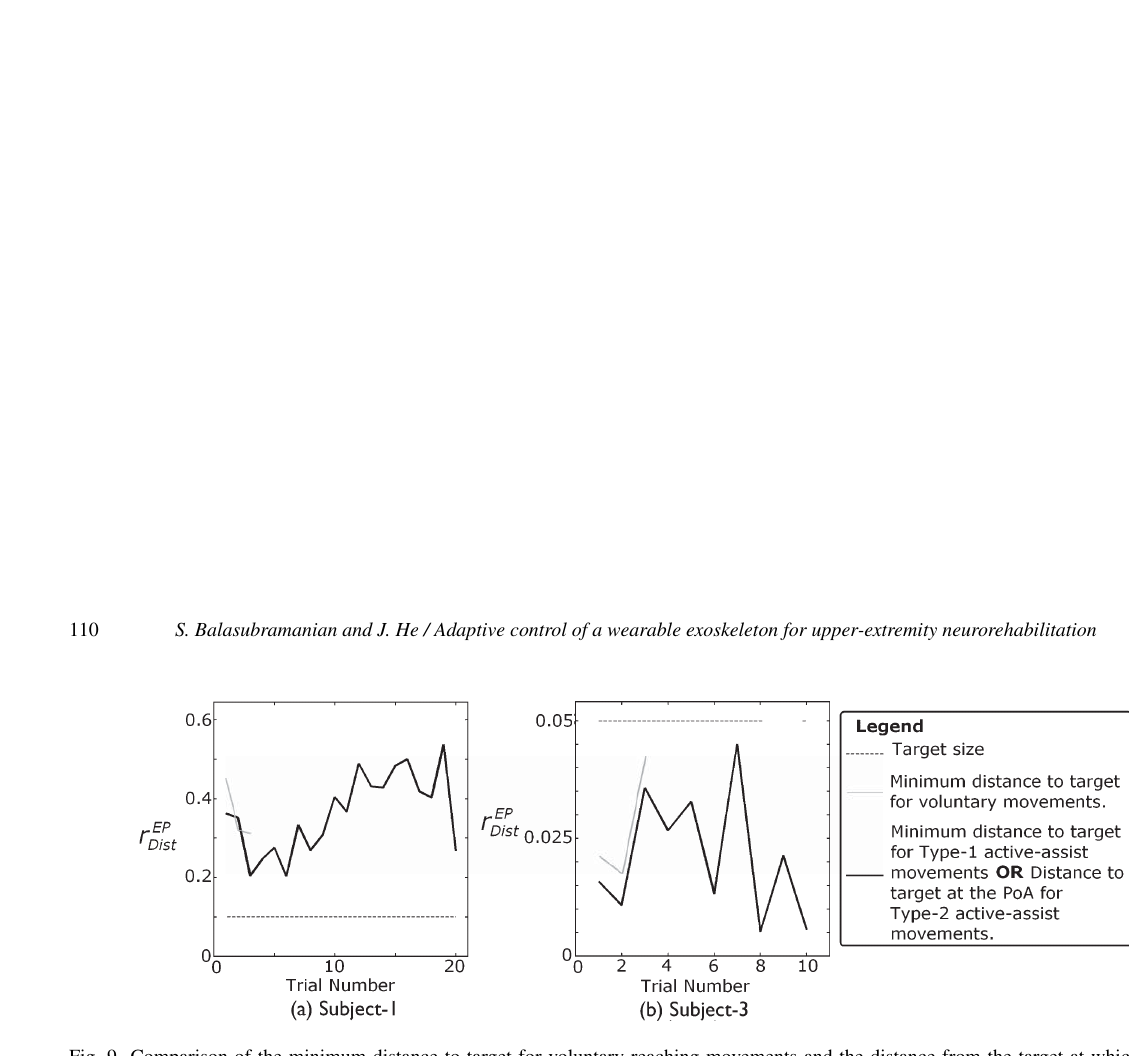
Fig. 9. Comparison of the minimum distance to target for voluntary reaching movements and the distance from the target at which robotic assistance is initiated in AAM reaching movements for subject-1 and subject-3 reaching to Target